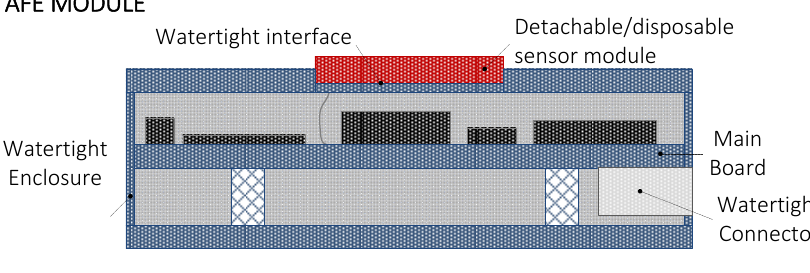
Figure 4. AFE module concept. Figure 4 . AFE module concept .